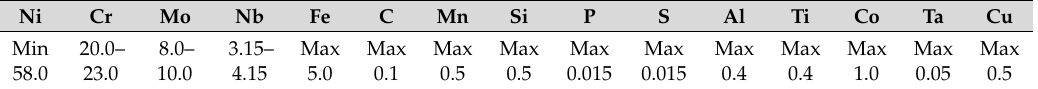
Table 1. Chemical composition of Inconel 625 Ni-based